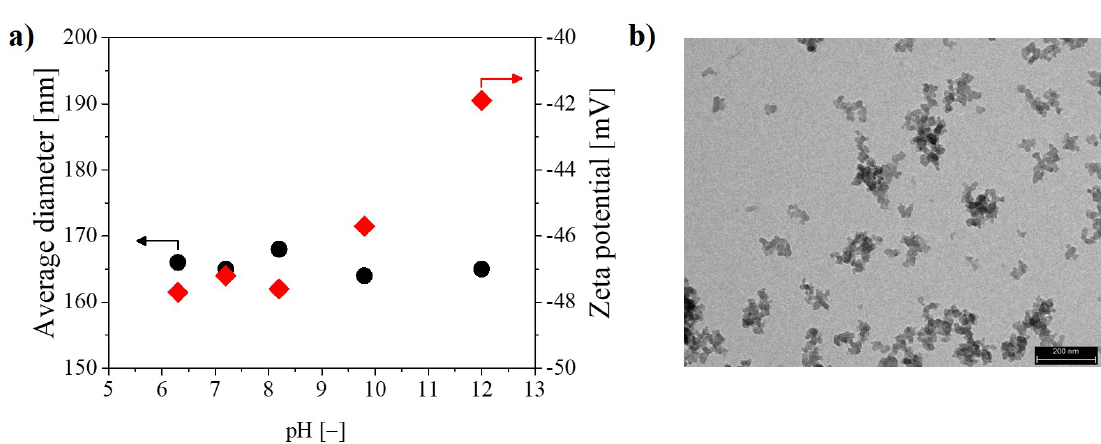
Figure 1. ( a ) Average diameter and zeta potential of the silica NPs as a function of pH in the silica dispersion. ( b ) TEM image of the dried silica NPs (scale 200